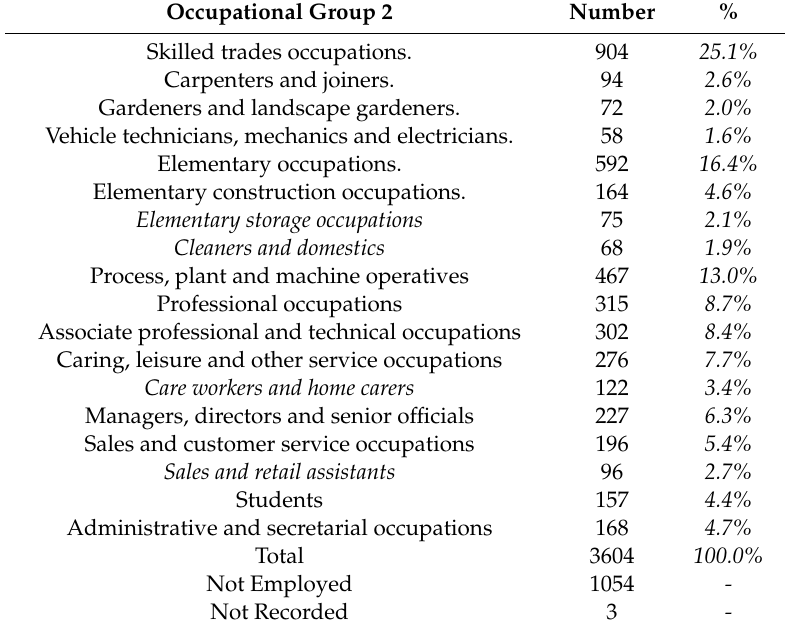
Table 2. Suicide by occupational group (16–64-year